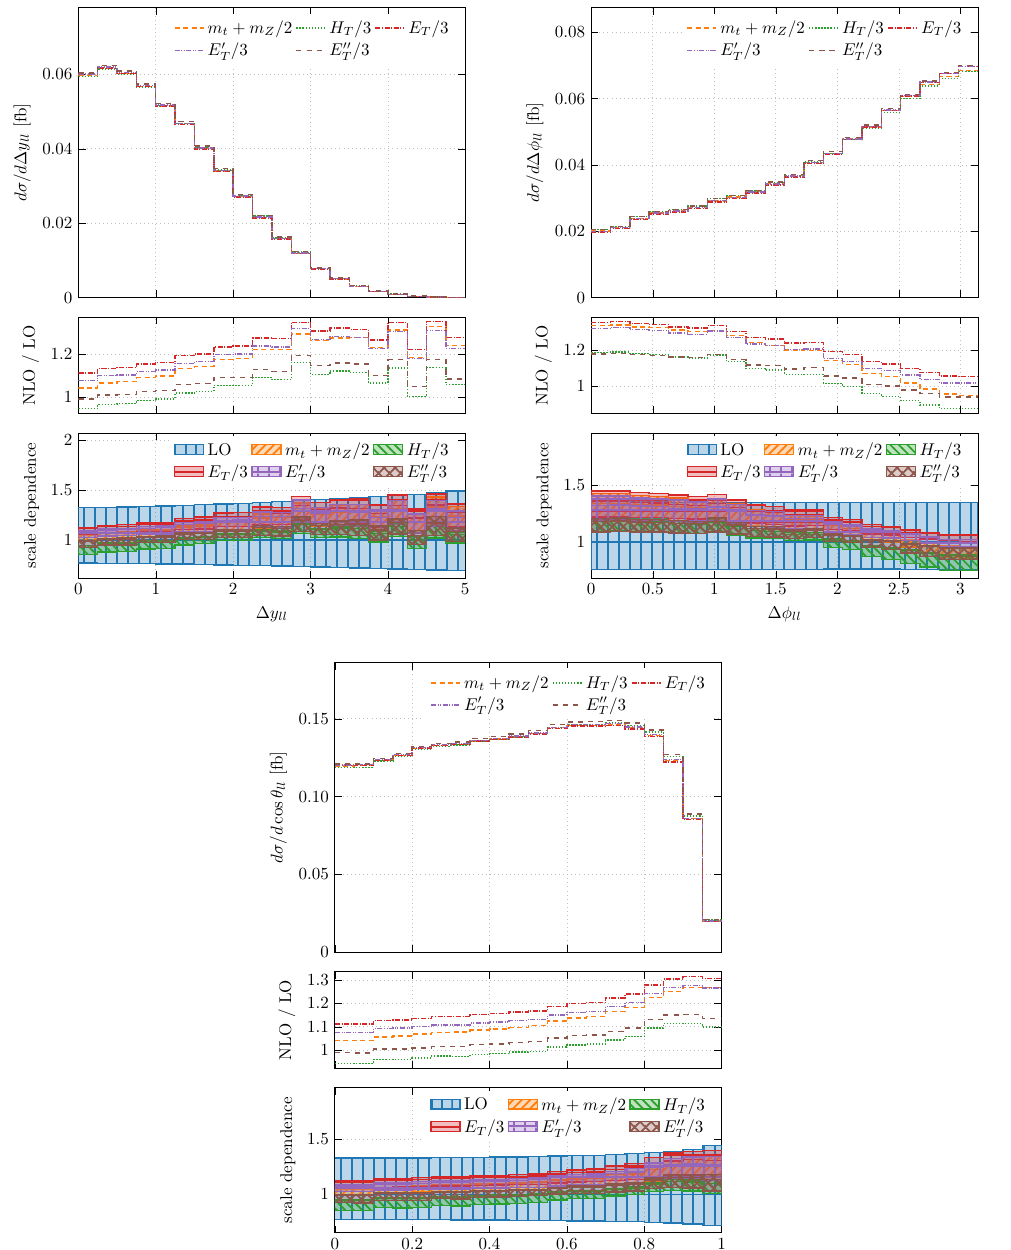
Figure 8 . The pp e + (cid:23) e (cid:22) (cid:0) (cid:22) (cid:23) (cid:22) b (cid:22) b (cid:23) (cid:28) (cid:22) (cid:23) (cid:28) + X di(cid:11)erential cross section distribution as a function ! of (cid:1) y ‘‘ = y ‘ y ‘ , (cid:1) (cid:30) ‘‘ = (cid:30) ‘ (cid:30) ‘ and cos (cid:18) ‘‘ = tanh((cid:1) y ‘‘ = 2) at the LHC run II with 1 (cid:0) 2 j 1 (cid:0) 2 j j j p s = 13 TeV. The upper plots show absolute NLO QCD predictions for various values of (cid:22) 0 where (cid:22) R = (cid:22) F = (cid:22) 0 . The middle panels display di(cid:11)erential factors. The lower panels present K di(cid:11)erential factors together with the uncertainty band from the scale variation for various values K of (cid:22) 0 . Also given is the relative scale uncertainties of the LO cross section for (cid:22) 0 = m t + m Z = 2. The LO and the NLO CT14 PDF sets are employed.